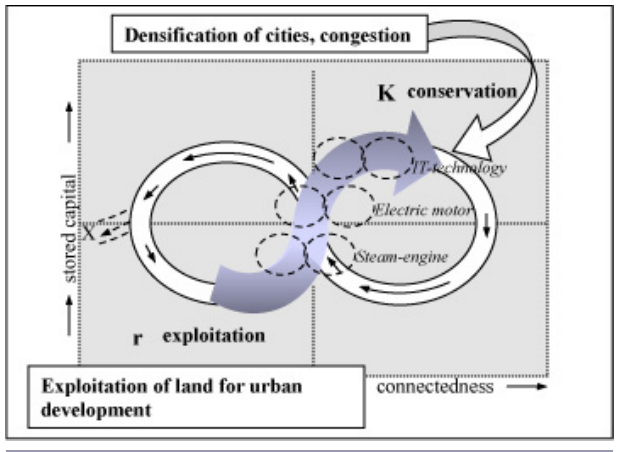
Fig. 2 . Urban growth in the context of the adaptive